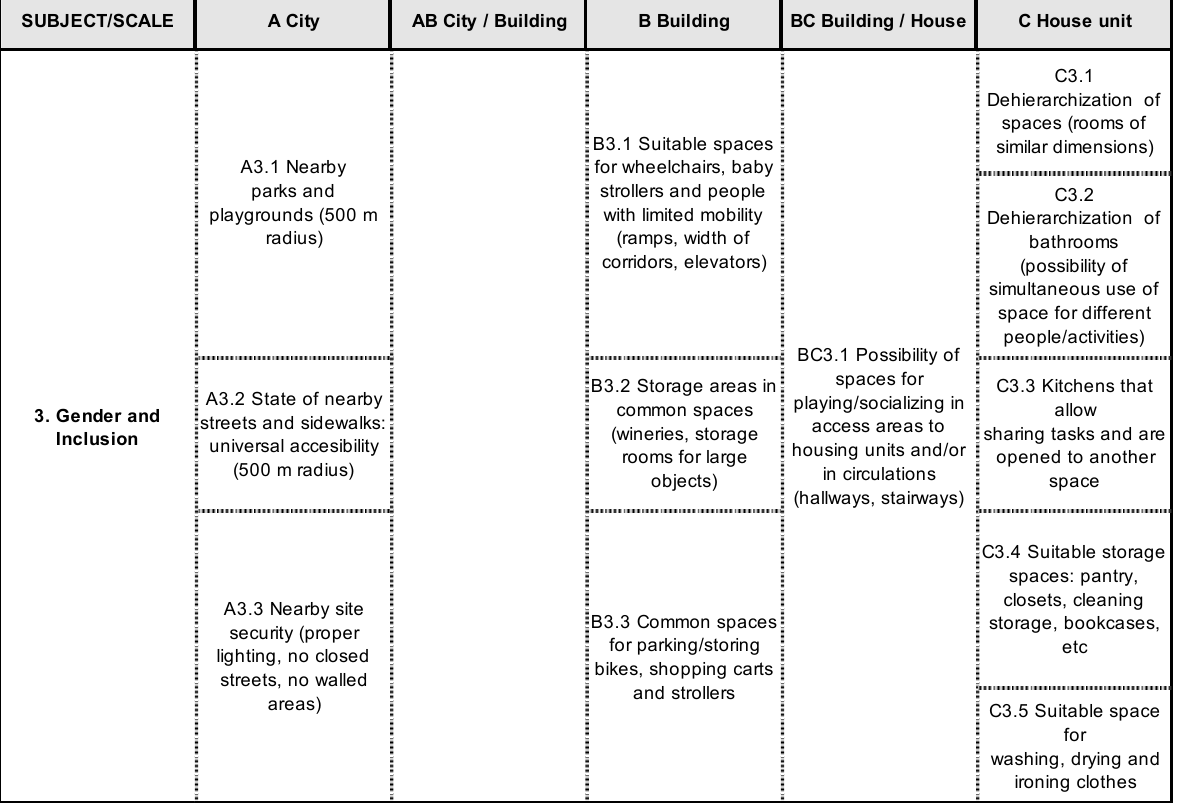
Figure 3. Gender and Inclusion Indicators. Source: Own elaboration. Category 4: Spatial Quality indicators are related to materiality, architectural quality,